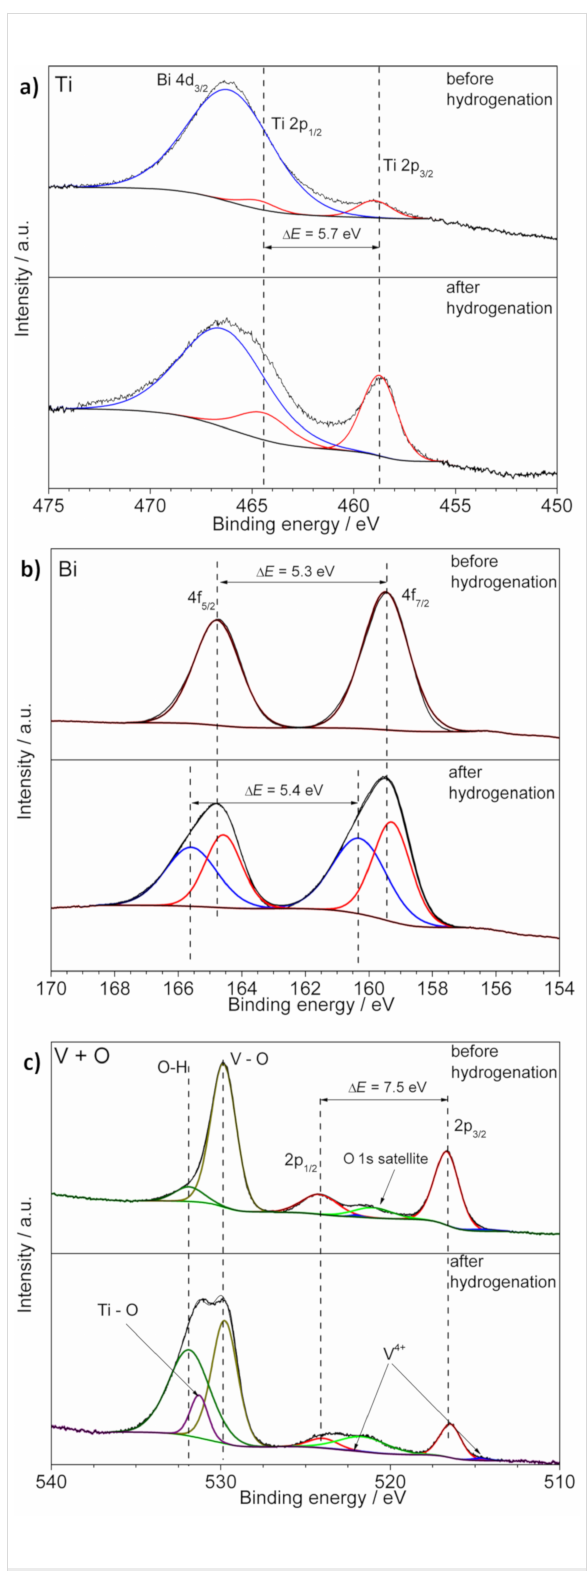
Figure 3: XPS spectra of a) Ti 2p region, b) Bi 4f region, and c) O 2p and V 2p regions for as-prepared and hydrogenated (Ti/TiO 2 /BiVO 4 and Ti/TiO 2 :H/BiVO 4 :H)